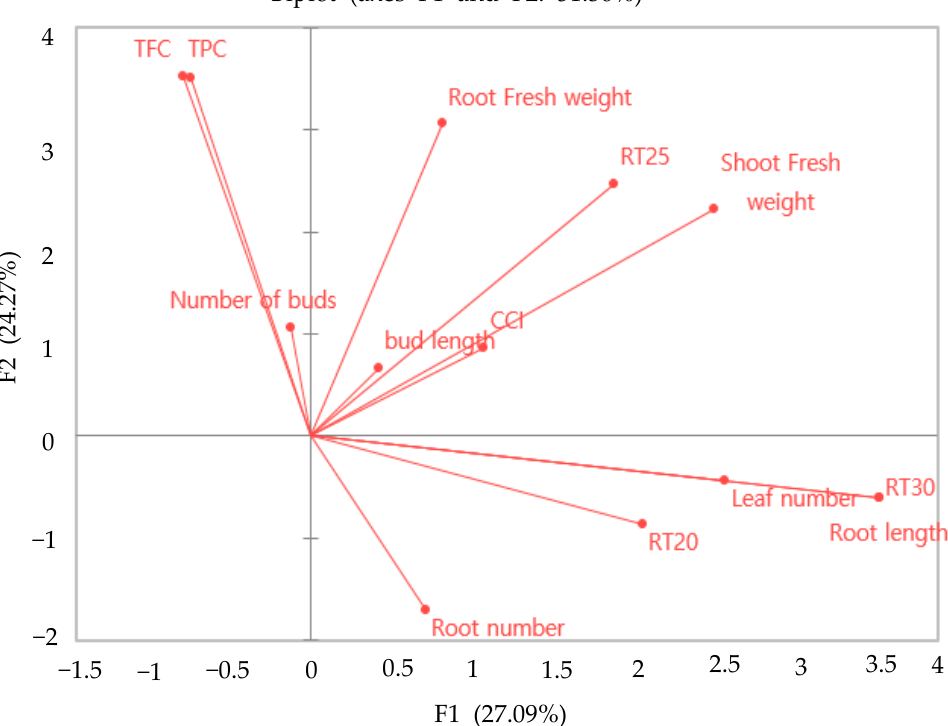
Figure 9. Principal component analysis results obtained for the qualitative morphological and physiological traits of C. indicum . RT20, room temperature of 20 ◦ C; RT25, room temperature of 25 ◦ C; RT30, room temperature of 30 ◦ C; CCI, chlorophyll content index; TPC, total phenolic content; TFC, total flavonoid content.